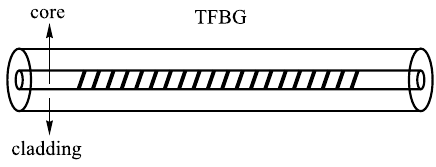
Fig. 4 Schematic diagram of the tilted fiber Bragg grating